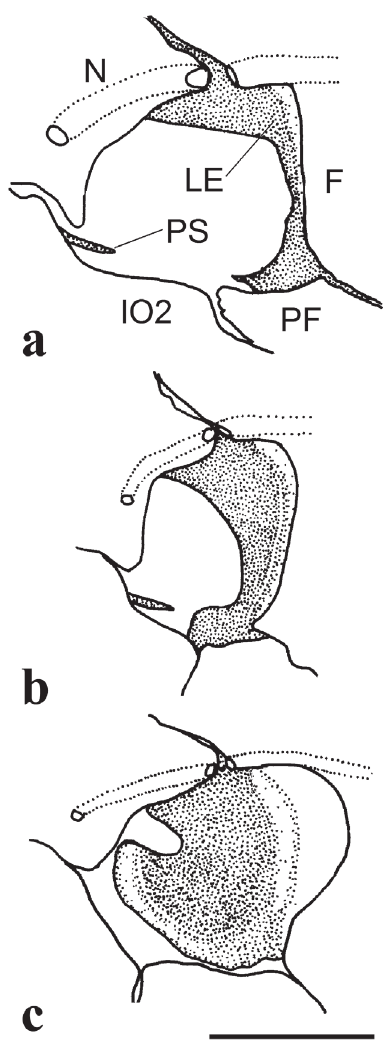
Fig. 6. Expansion of the subnasal lamina (stippled) of the lateral ethmoid of Otocinclus . Left naris of a , O . arnoldi (MCP 26864); b , O . cocama (MCP 34842); and c , O . mura (MCP 22550). F - frontal, IO2 - infraorbital 2, LE - lateral ethmoid, N - nasal, PF - prefrontal plate, PS - palatine sesamoid. Snout tip towards left. Scale = 1 mm.